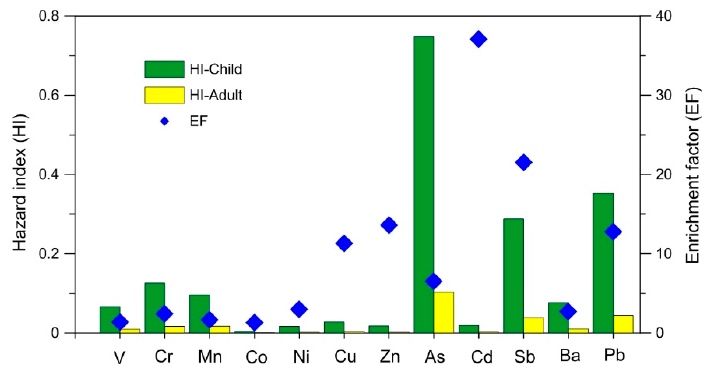
Figure 4. A comparison of health risks for children and adults and EFs of potentially toxic elements in settled dust in the Beijing urban area.